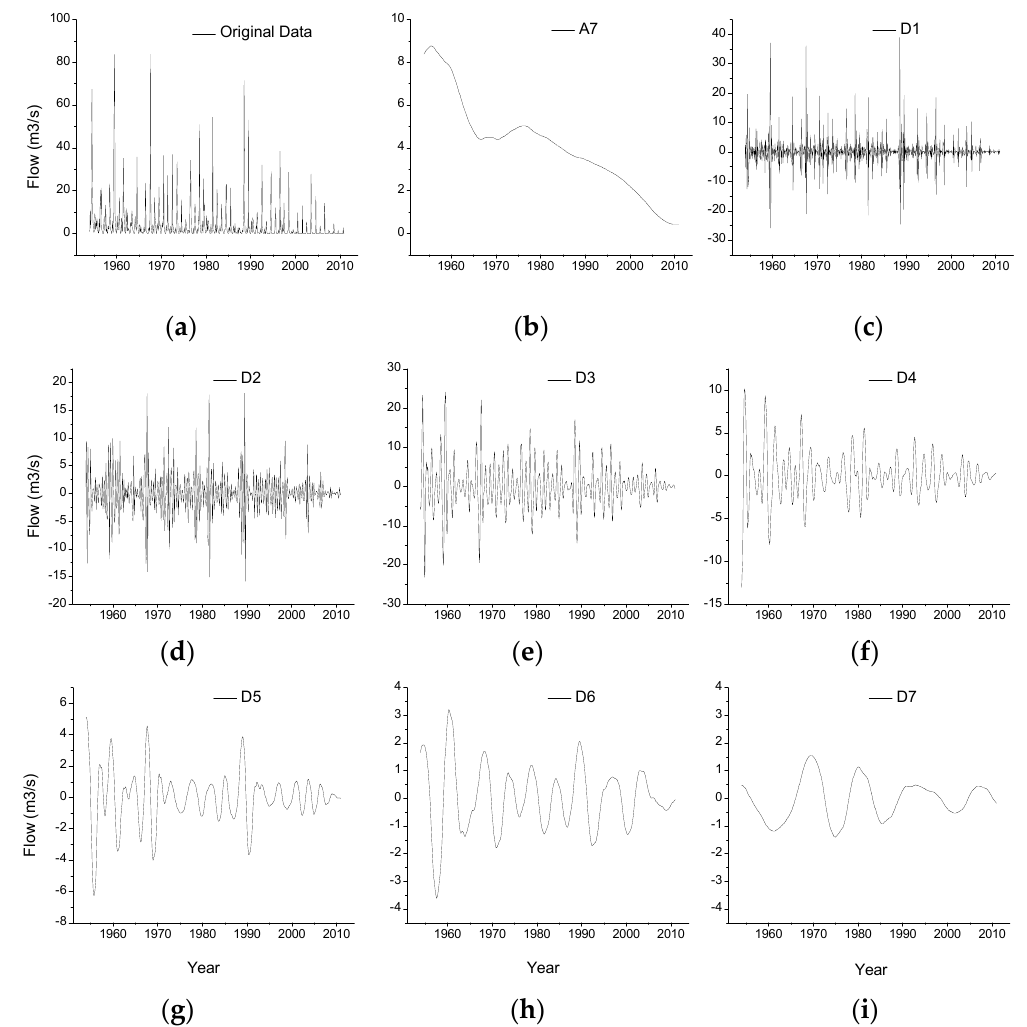
Figure 7. Original monthly mean streamflow series and its approximation (A7) and detail components (D1–D7) decomposed via DWT. ( a ) original data; ( b ) A7; ( c ) D1; ( d ) D2; ( e ) D3; ( f ) D4; ( g ) D5; ( h ) D6; ( i ) D7.